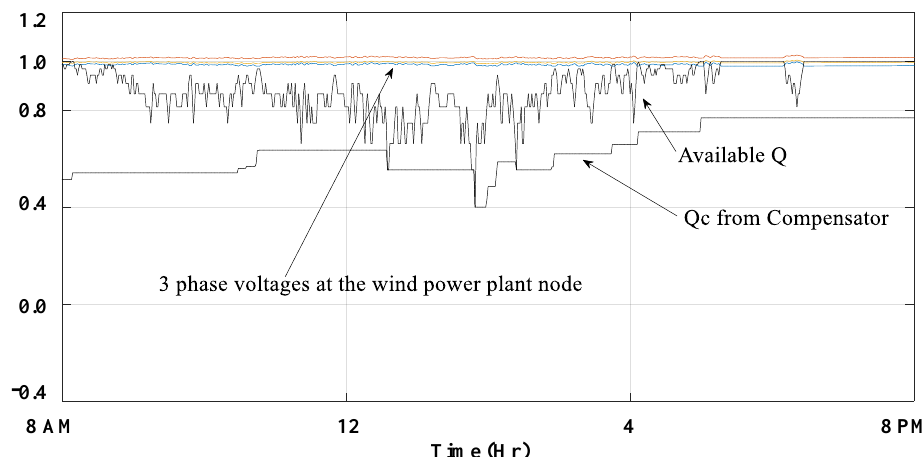
Figure 14. The phase voltages (p.u.), the available reactive from the WPP 𝑄 (p.u.), and reactive power compensation 𝑄 𝑐 (p.u.) when the regulators are de-energized.